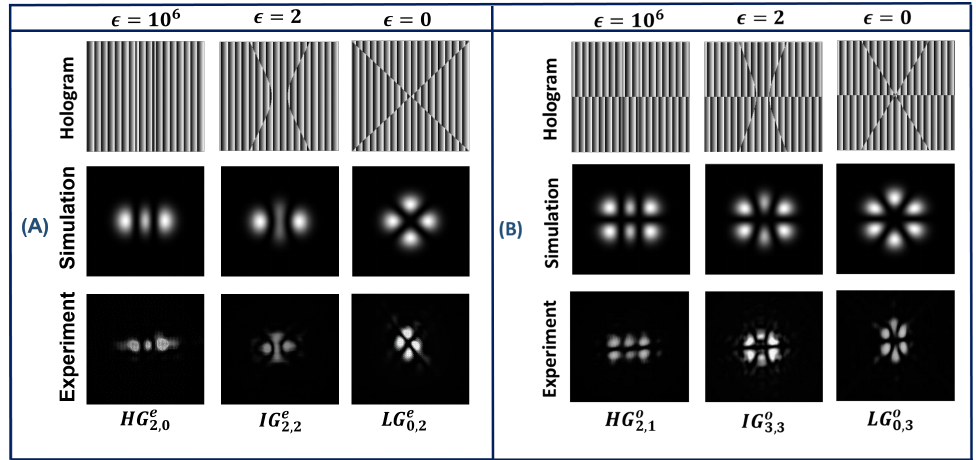
Figure 11. ( A ) Conversion of IG e beam (third column) for different (cid:101) values. ( B ) Conversion of IG o beam (first column) and LG o